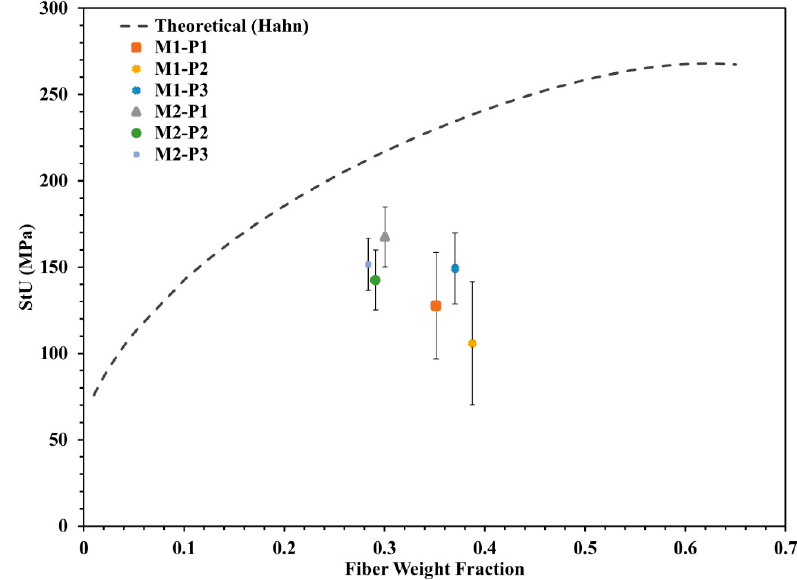
Figure 10. Average tensile strength vs. the fiber fraction weight of each of the plates from the sets of each method. The blue curve represents the theoretical value calculated based on the Hahn’s equation .